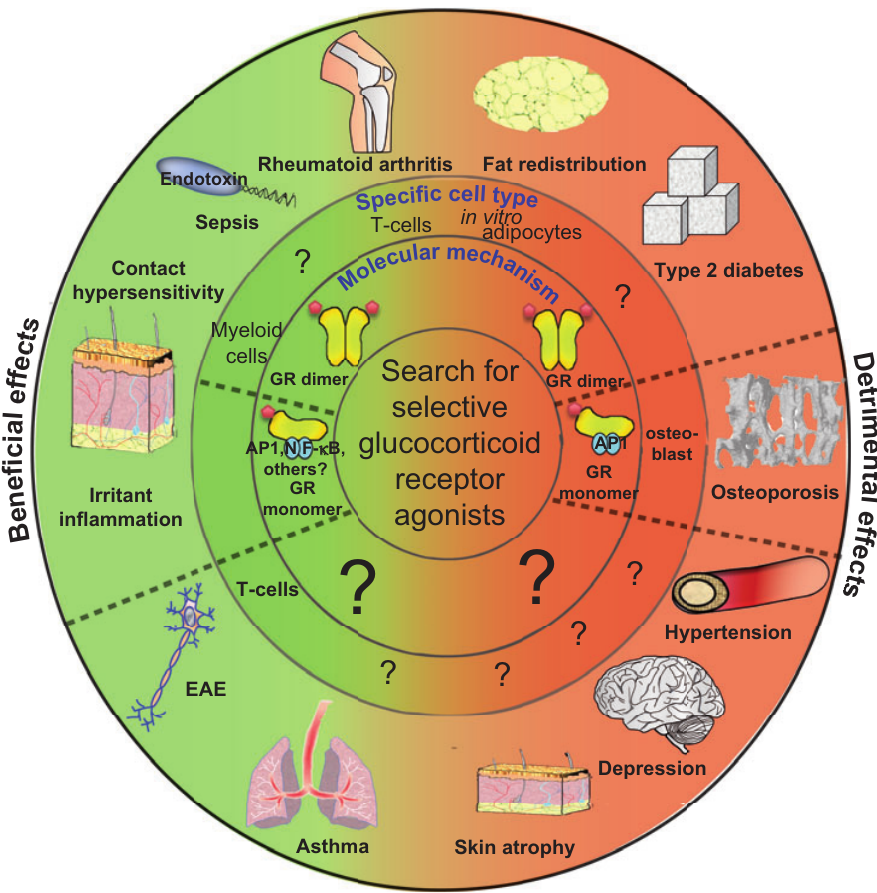
Figure 2 Different physiological processes in steroid therapy require cell-type-specifi c modes of GR action. Shown is a graphical summary of the results from analyses of GR dimer-defi cient and cell-type-specifi c GR knockout mice in benefi cial (left) and detrimental effects (right) of GC therapy. For benefi cial anti-infl ammatory effects of GCs (left), GR dimerization is required in animal models for arthritis, sepsis, and contact allergy. For irritant infl ammation, the monomer GR activity is suffi cient; however, the involved inter- acting partners remain to be identifi ed. The GR in T cells is required for the immunosuppressive effects in an animal for model experimental autoimmune encephalomyelitis (EAE) and arthritis, whereas cell-type requirements for asthma have not been demonstrated. Detrimental side effects (right) of the GR dimer-dependent processes in adipocytes are important for differentiation and possibly for fat redistribution. Type 2 diabetes seems to be GR dimer dependent, which has to be further investigated. Monomer GR-AP-1 interaction is critical for GC-induced osteoporosis. Models for hypertension, brittleness of the skin and depression remain to be analyzed with conditional GR knockout mice. Selective GR modulators should fulfi ll the molecular requirements, specifi cally for individual infl ammatory diseases, and then should exert distinct capacities to reduce side